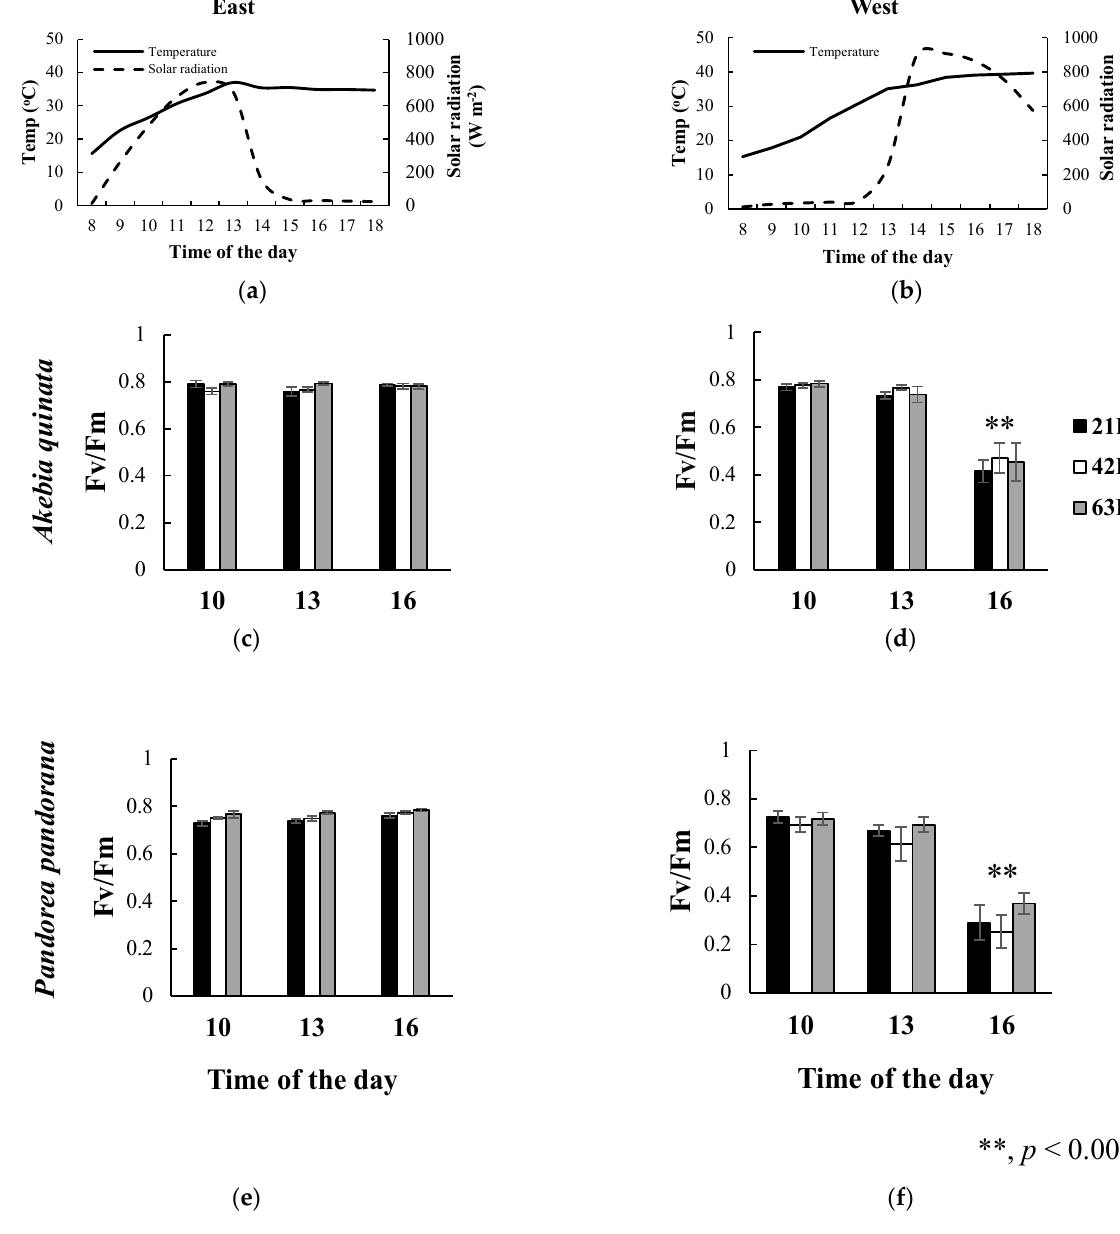
Figure 5. Daytime changes of air temperature and solar radiation of east-facing ( a ) and west-facing façades ( b ) on a clear summer day in March 2018. Variation of the Fv/Fm ratio of Akebia quinata ( c , d ) and Pandorea pandorana ( e , f ) grown in different rooting volumes in response to the changes of air temperature and solar radiation. Values are means ± SE for three different leaves.